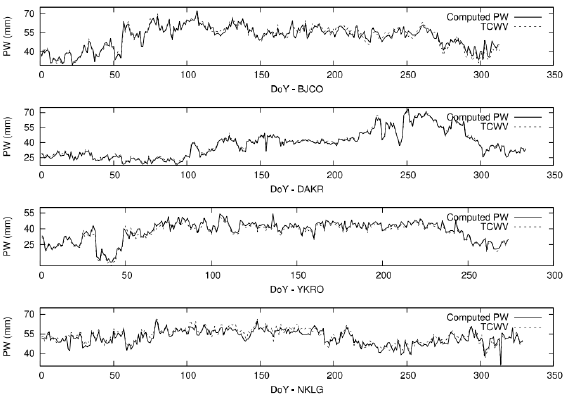
Table 5: R 2 and RMSE for the computed PW and predicted PW